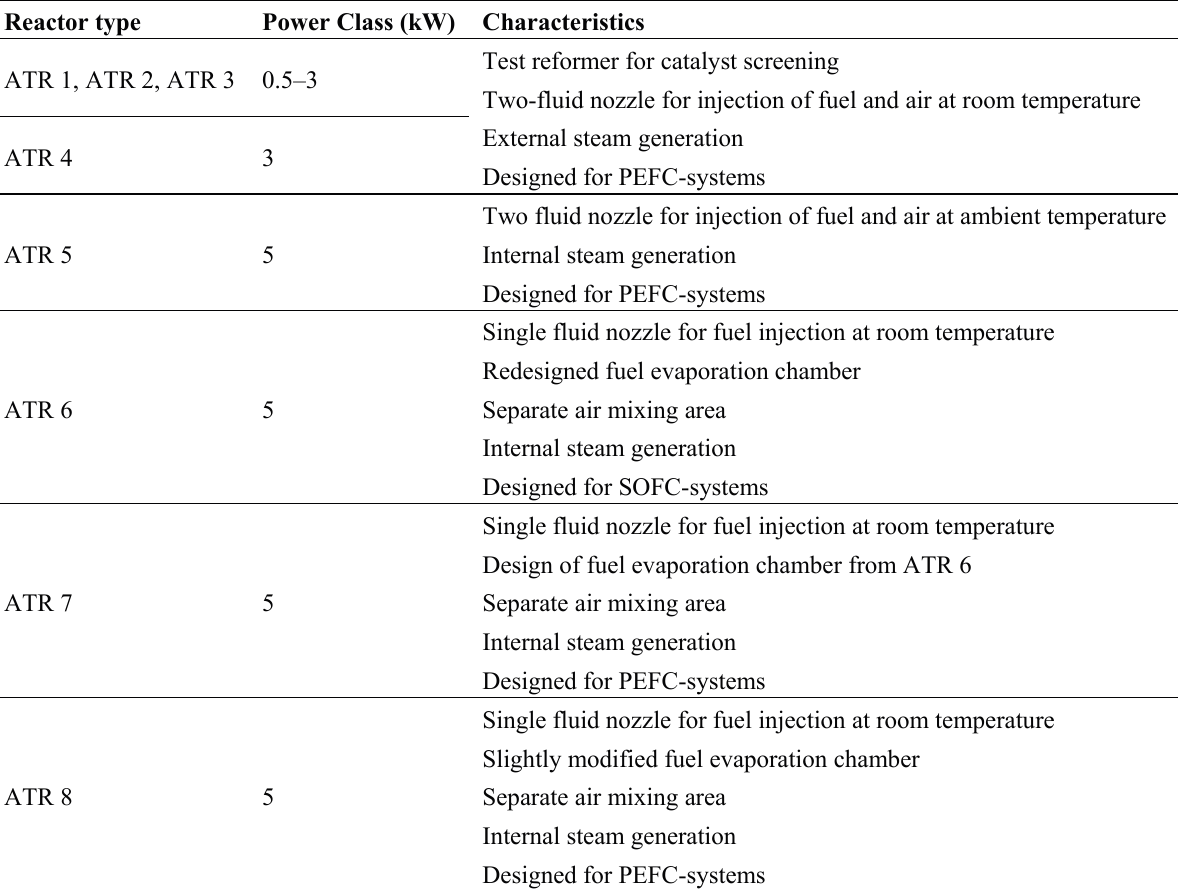
Table 2. Reactors and their